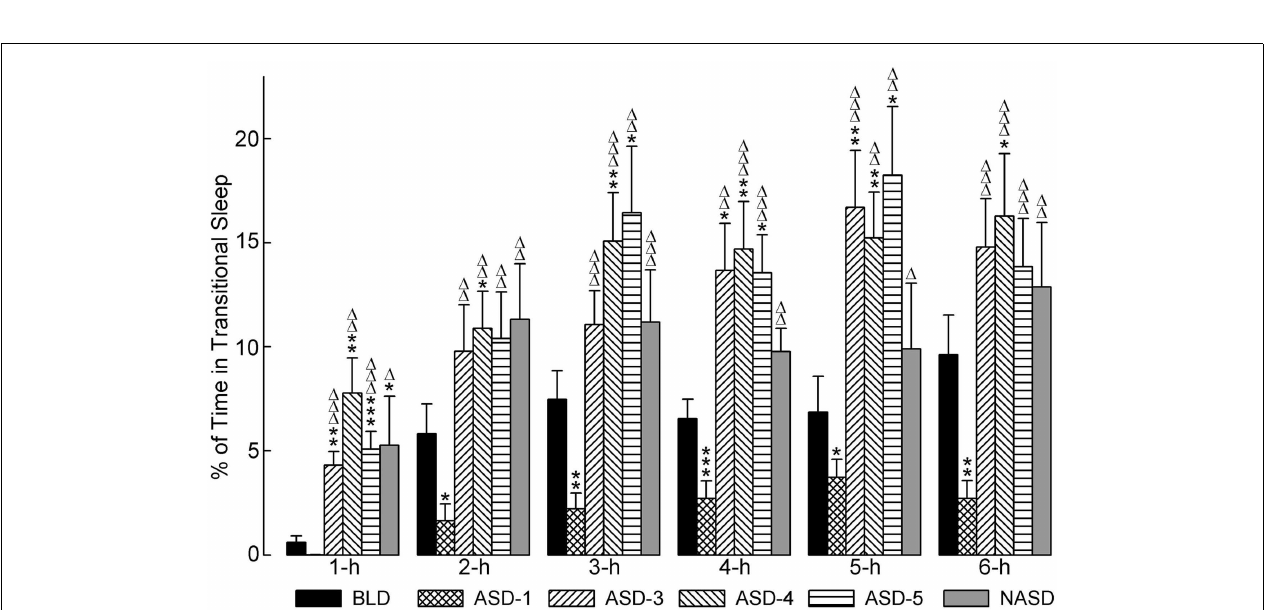
FIGURE 3 | Progressive effects of repetitive anxiogenic stressor (AS) exposure on the percentages (mean ± SEM) of time spent in slow-wave sleep for each hour of the 6h sleep-wake recording period immediately following experimental treatment. The treatments, listed chronologically: no exposure to AS baseline day (BLD), day 1 of AS